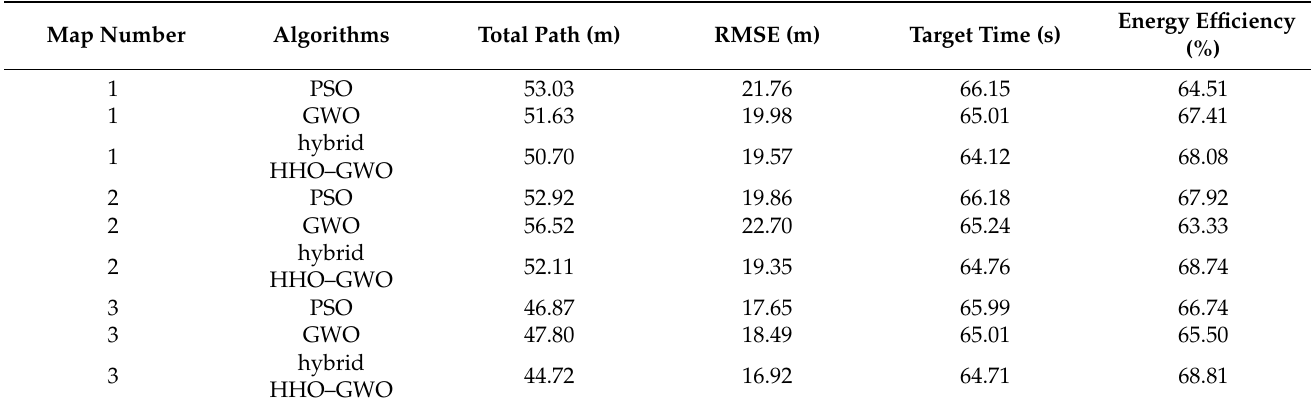
Table 5. Performance criteria of metaheuristic optimization algorithms for path planning and